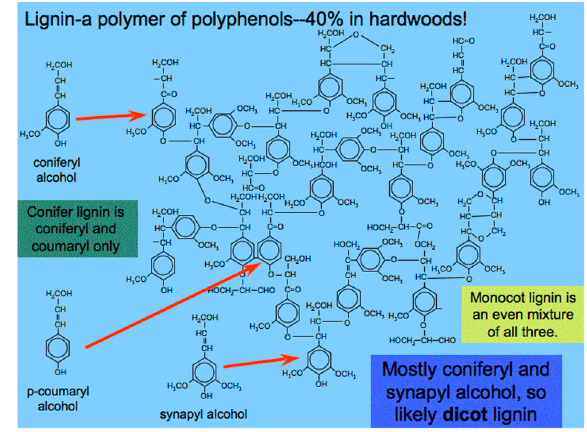
Figure 9. Chemical structure of lignin.